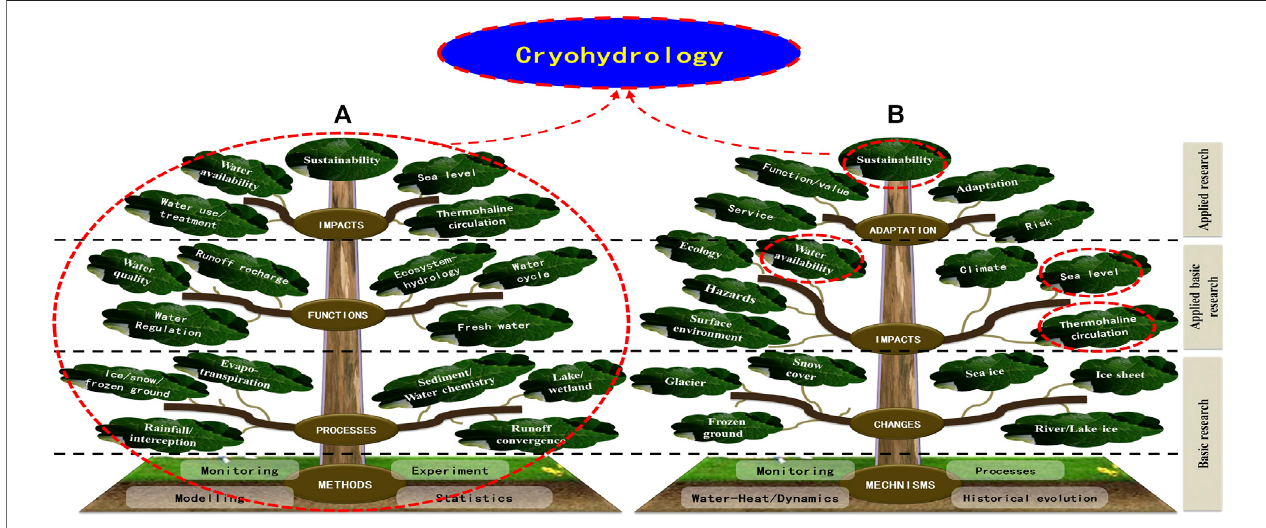
FIGURE1| Researchcontenttreeofhydrology (A) and (B) cryosphericscience(afterQinetal.,2018)aswellasandtherelationshipbetweenhydrology,cryohydrology, and cryospheric science. Note that cryohydrology focuses on the water cycle and water availability, and the intersection between cryospheric science and hydrology.